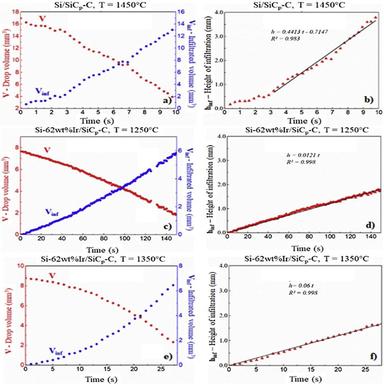
Evolution of drop emerging volume (V), infiltrated volume (Vinf), and height of infiltration (hinf) for experiments performed on SiCp-C porous preforms by infiltrating: a) and b) pure Si at T = 1450 °C; c) and d) Si-Ir eutectic alloy at T = 1250 °C and e) and f) Si-Ir eutectic alloy at T = 1350 °C. The linear equation and standard deviation are inserted.